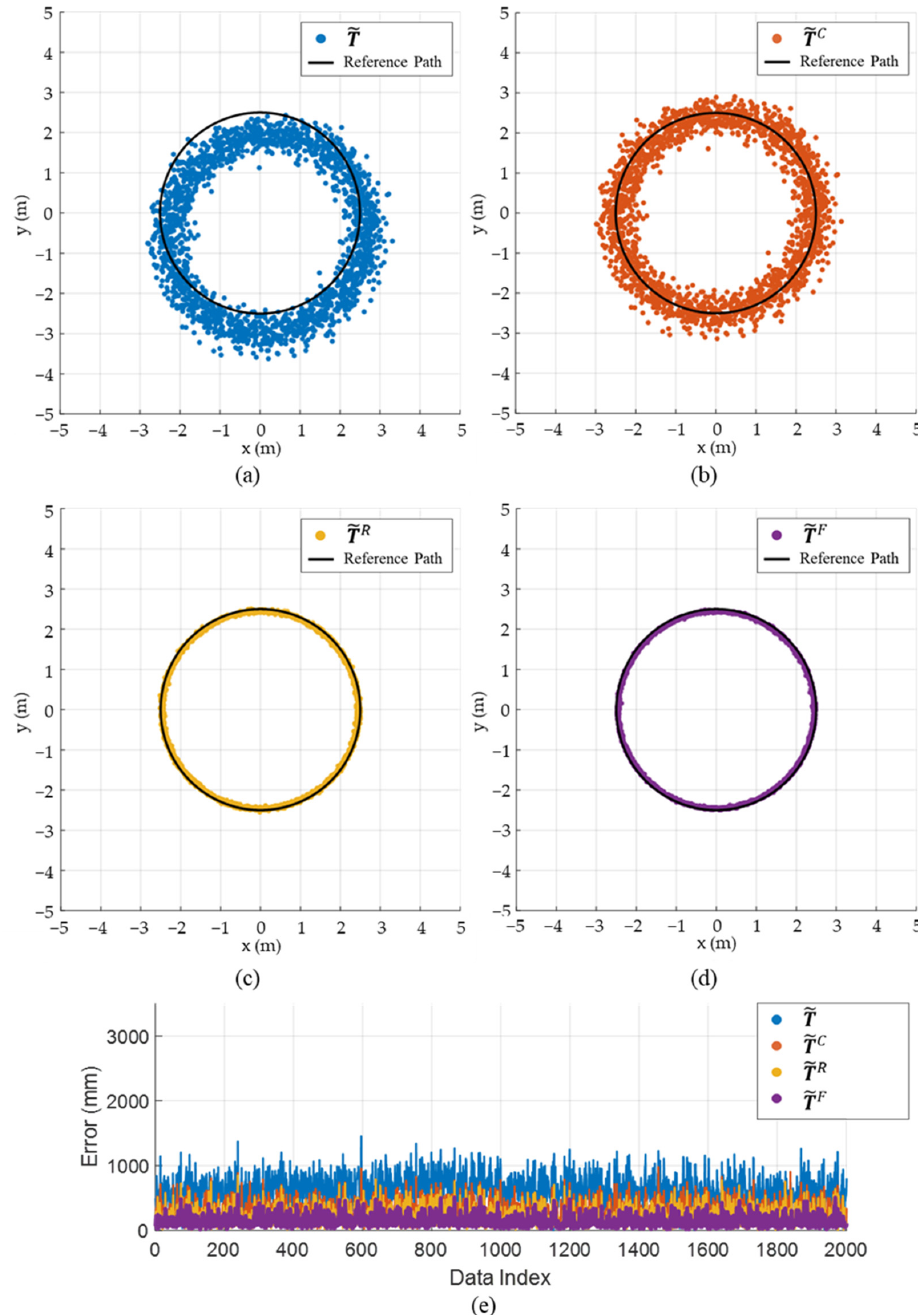
Figure 9. Simulation results demonstrating the estimation accuracy of the proposed method for the circular path: ( a ) estimation results of 𝑻(cid:3561) , ( b ) estimation results of 𝑻(cid:3561) (cid:3004) , ( c ) estimation results of 𝑻(cid:3561) (cid:3019) , ( d ) estimation results of 𝑻(cid:3561) (cid:3007) , ( e ) comparison of estimation error for 𝑻(cid:3561),𝑻(cid:3561) (cid:3004) ,𝑻(cid:3561) (cid:3019) ,and 𝑻(cid:3561) (cid:3007) .